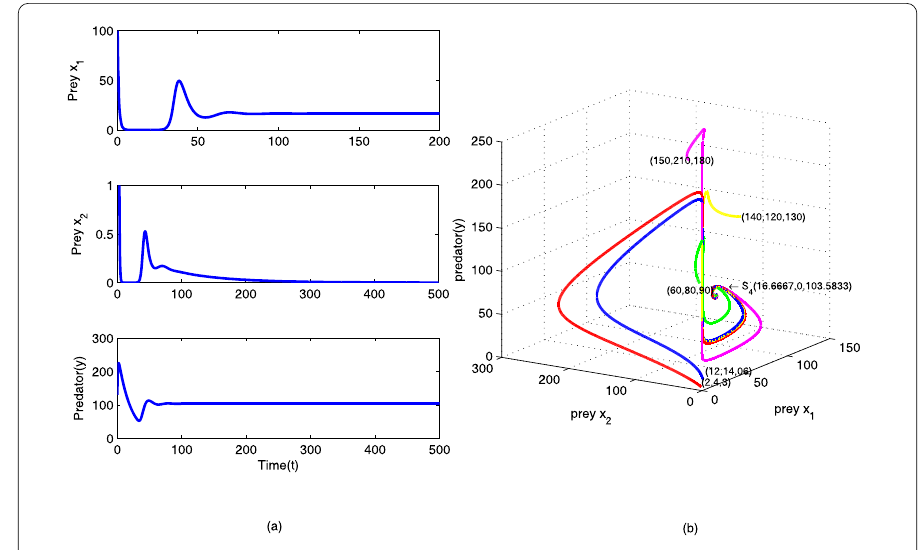
Figure 5 Numerical simulation of model (2.1) around the boundary state S 4 . S 4 (16.6667,0,103.5833) with E 1 = 22, E 2 = 35. Different color curves represent different initial conditions. The other parameter values are given in (7.1) and ( k 1 , k 2 ) =